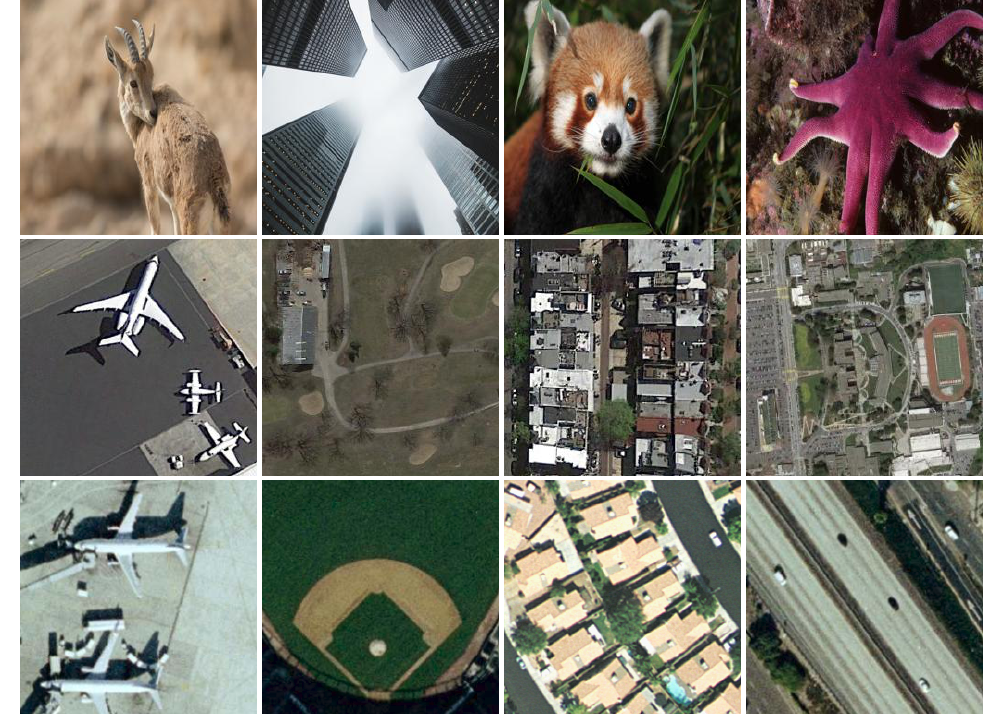
Figure 7. Datasets in the paper. The first row depicts images from the DIV2K dataset. The sec- ond row shows images from the UC Merced dataset, and the last row shows images from the NWPU-RESISC45